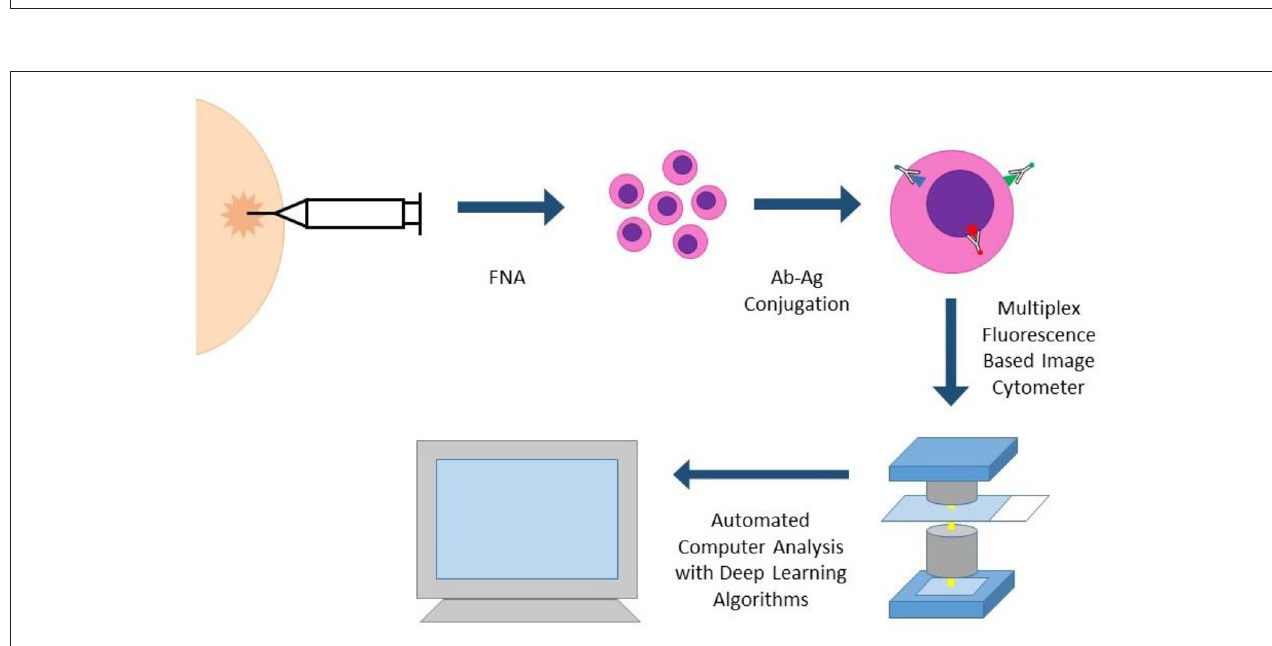
FIGURE 4 | CYTO-PAN (portable fluorescence-based image cytometry analyser). This specific system was used to diagnose and subtype breast cancer in FNA specimens. FNA biopsy samples are processed with prefabricated kits with preselected antibodies. Slides with stained cells are analyzed by the CytoPAN device, a fluorescence based image cytometer with five optical channels. Custom-developed algorithms identify cancer cells and biomarker information, producing quantitative reports. The entire process could be performed within 1h.